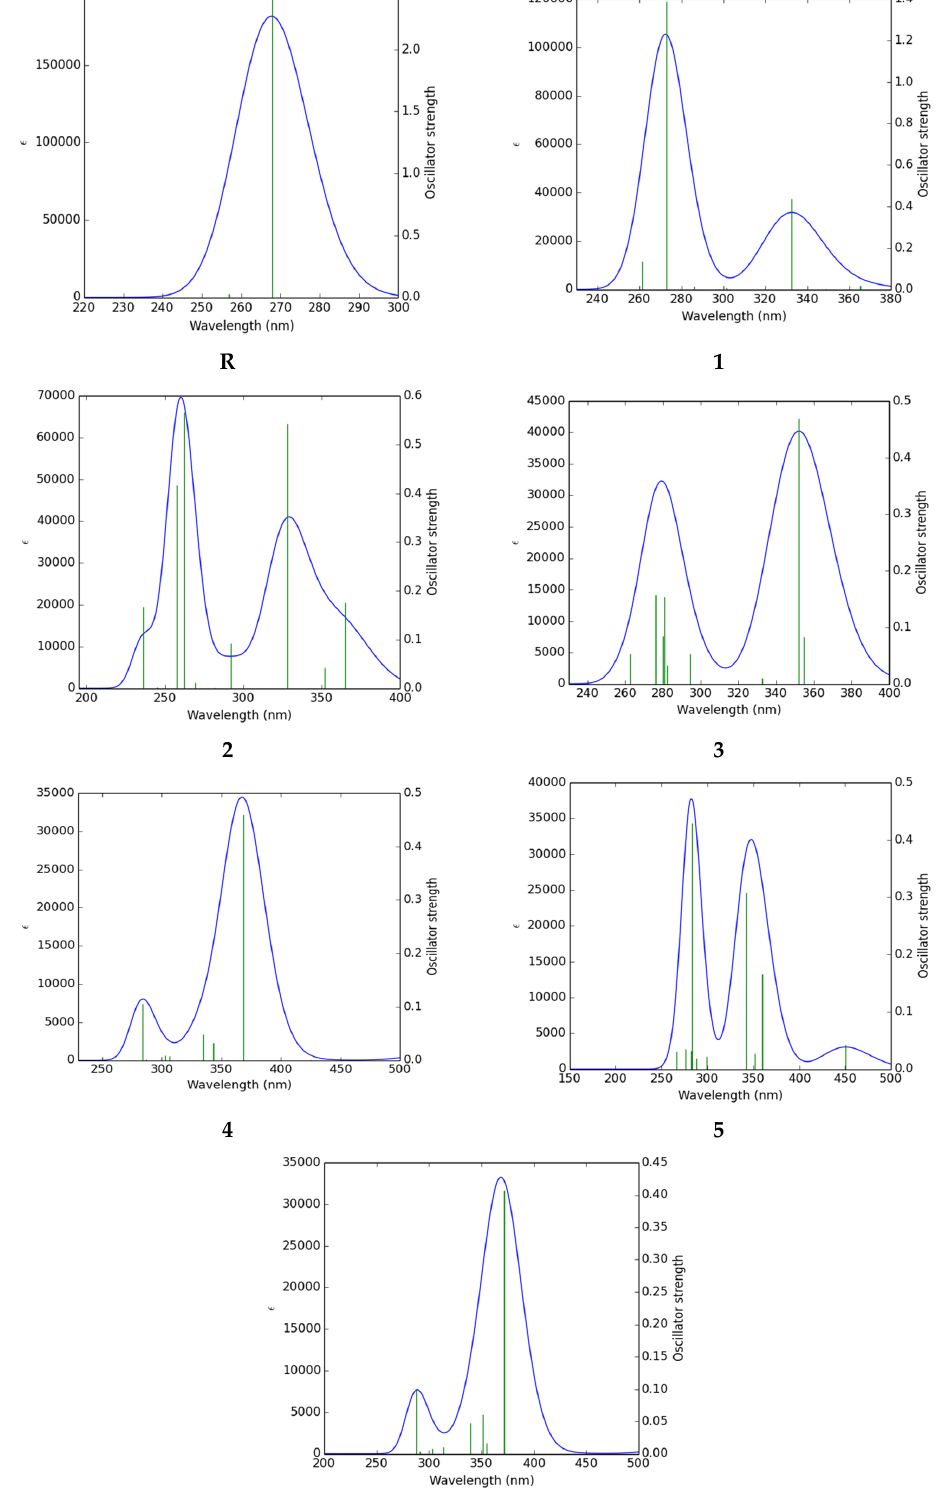
Figure 3. UV/Visible spectra of the studied compounds R and 1 – 6 . Figure 3. UV / Visible spectra of the studied compounds R and 1 – 6